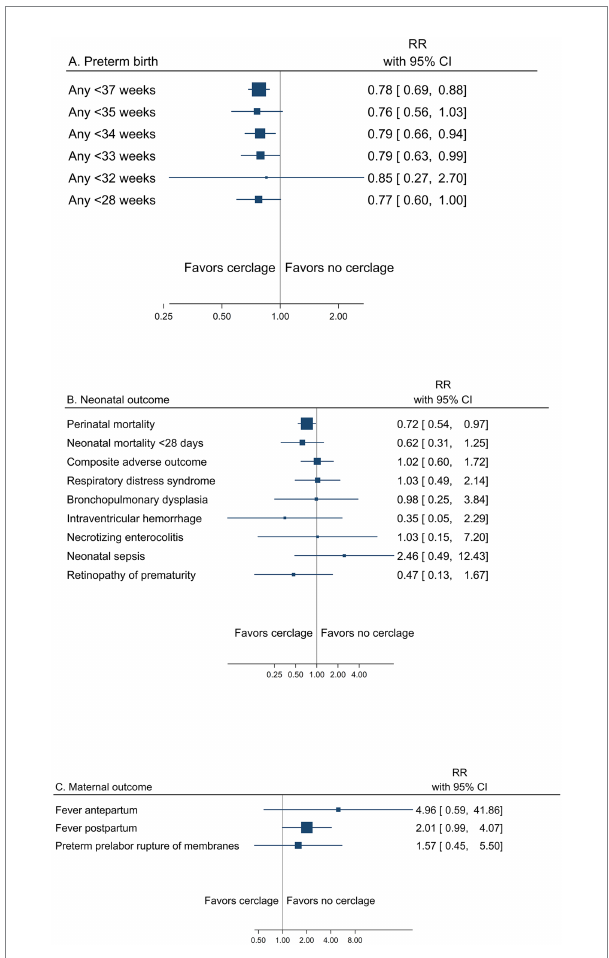
FIGURE 3 Summary graph of pooled estimates from meta-analyses comparing cerclage versus no cerclage in women with a singleton pregnancy and any type of risk factor for preterm birth, from trials with low risk of bias regarding (A) preterm birth, (B) neonatal, and (C) maternal